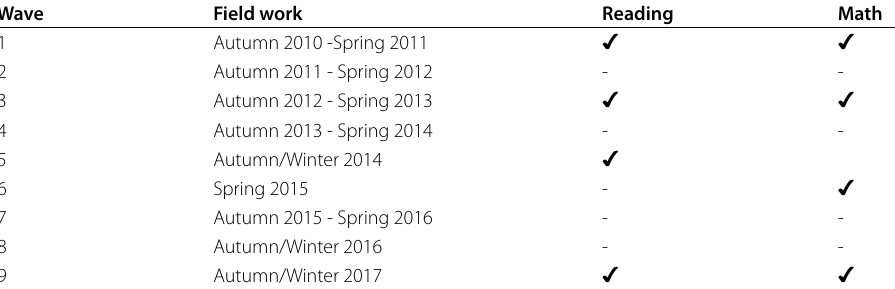
Table 1 Competence measures in NEPS SC3 by wave